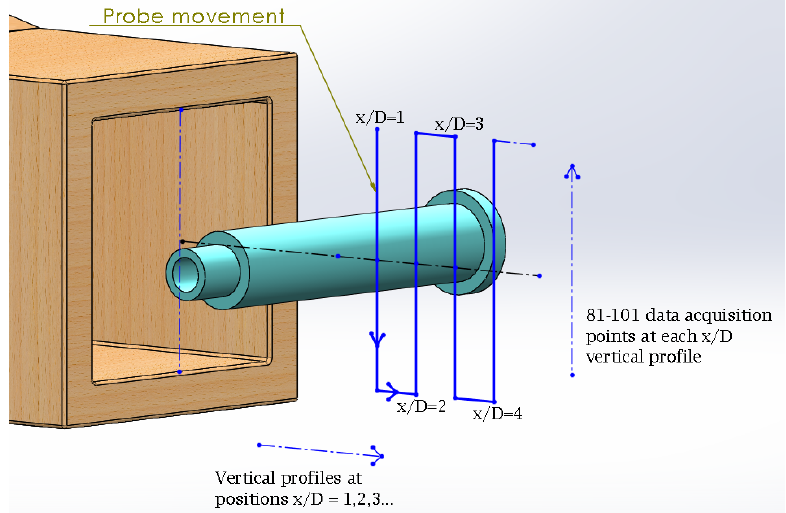
Figure 9. Probe movement path behind the